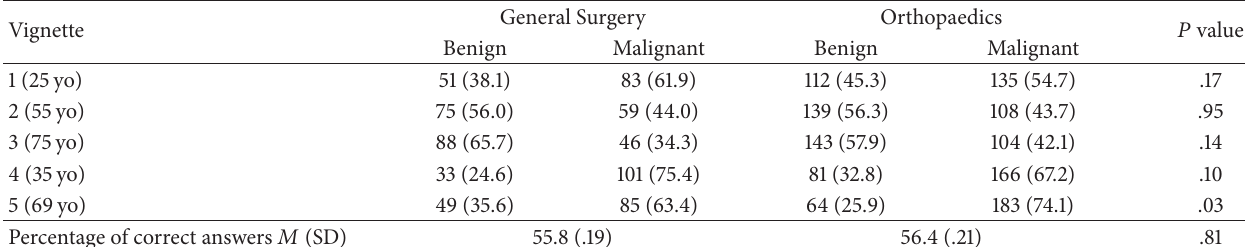
Table 2: Vignette responses by general surgery and orthopaedics residents.